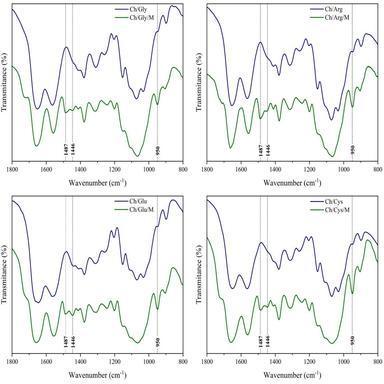
FT-IR spectra of methylated chitosan derivatives and their corresponding precursors.